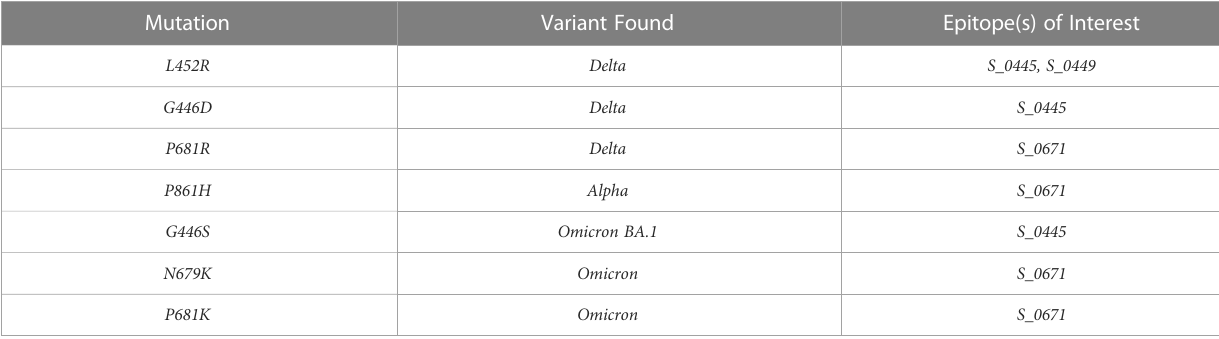
TABLE 3 Recurring mutations in